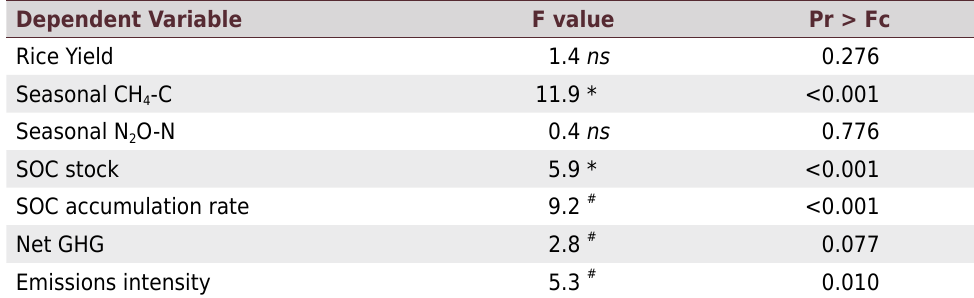
Table 2. Analysis of variance data (values of calculated F and P of analyzed variables) for seasonal emissions of CH 4 and N 2 O, stock and accumulation rate of soil organic carbon (SOC), net balance of GHG (net GHG), rice yield and emissions intensity in a subtropical Gleysol subjected to flooding rice production in Southern Brazil